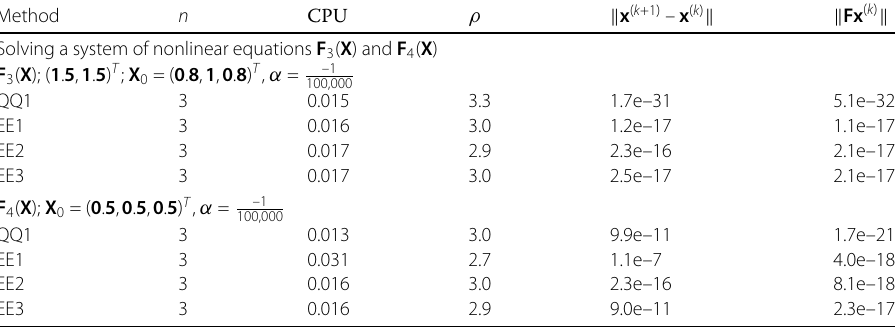
Table 5 Comparison of optimal 3rd order methods Method n CPU Solving a system of nonlinear equations F 3 ( X ) and F 4 ( X )